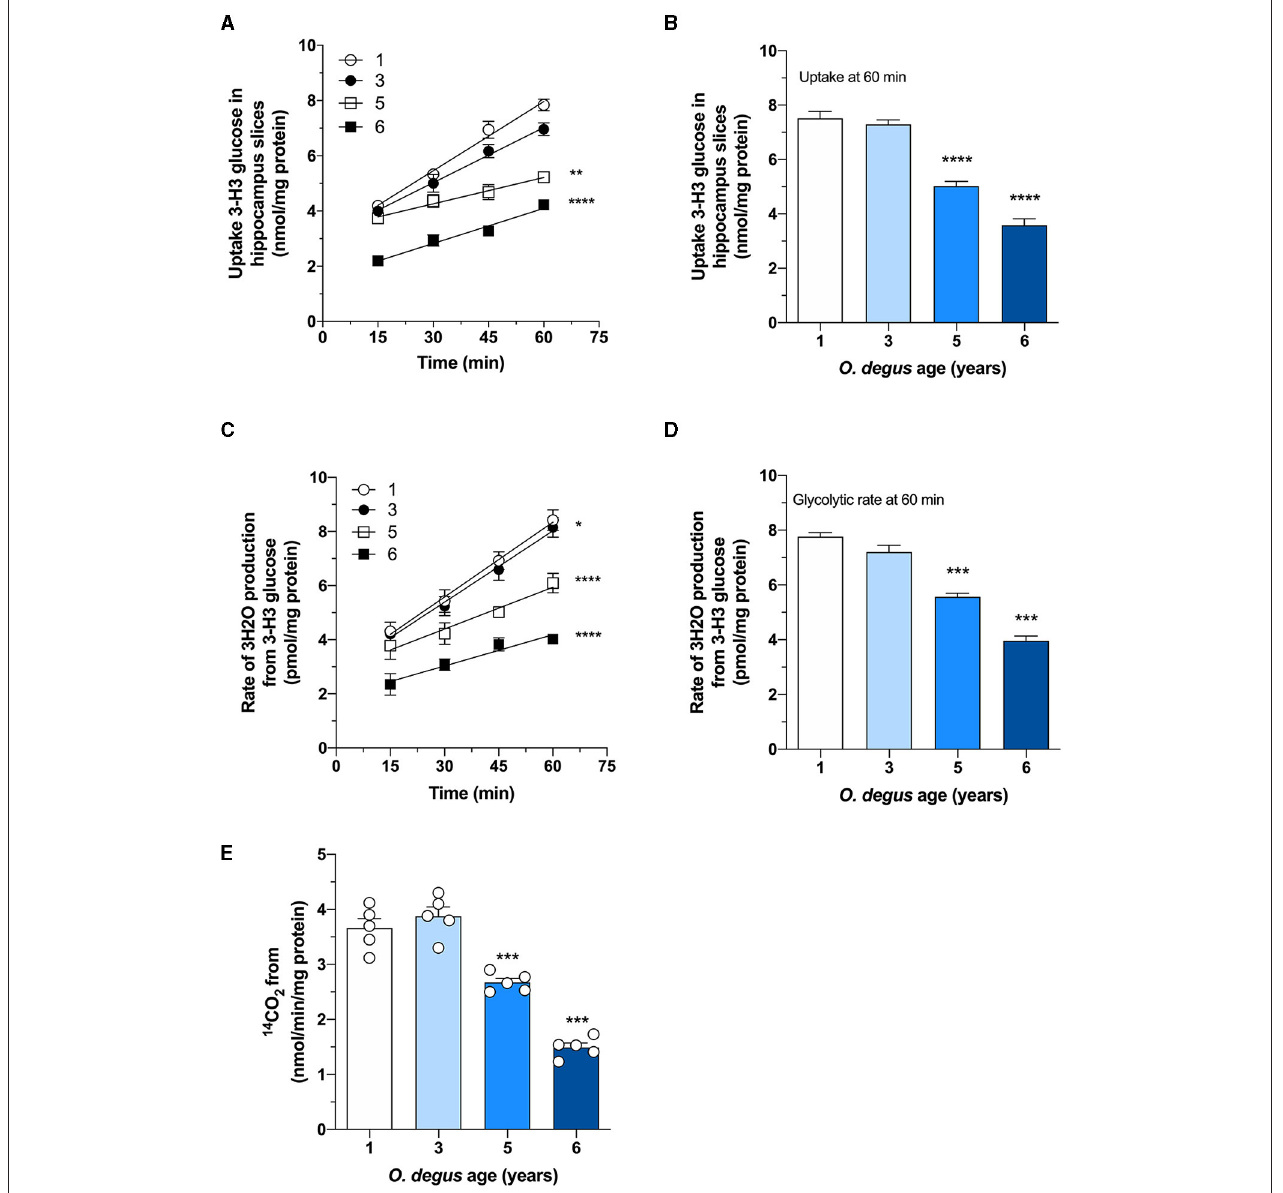
FIGURE 3 | Age-associated reduction in hippocampal glucose metabolism in degus. (A) Uptake of radioactive glucose in hippocampal slices obtained from 1- to 6-year-old degus was measured over 60min. (B) Glucose uptake at 60min of (A) . Hippocampal slices from 1-, 3-, 5-, and 6-year-old degus were analyzed for (C) glycolytic flux over 60min. (D) Quantification of glycolytic flux at 60min of (C) . (E) The pentose phosphate pathway (PPP) was measured in hippocampal lysates of 1- to 6-year-old degus. The data represent the mean ± SEM of five independent biological replicates in three technical replicates. Statistical significance: * p < 0.05, ** p < 0.01, *** p < 0.001, and **** p < 0.0001 by one-way ANOVA (B,D,E) or two-way ANOVA (A,C) , followed by Bonferroni’s post-hoc